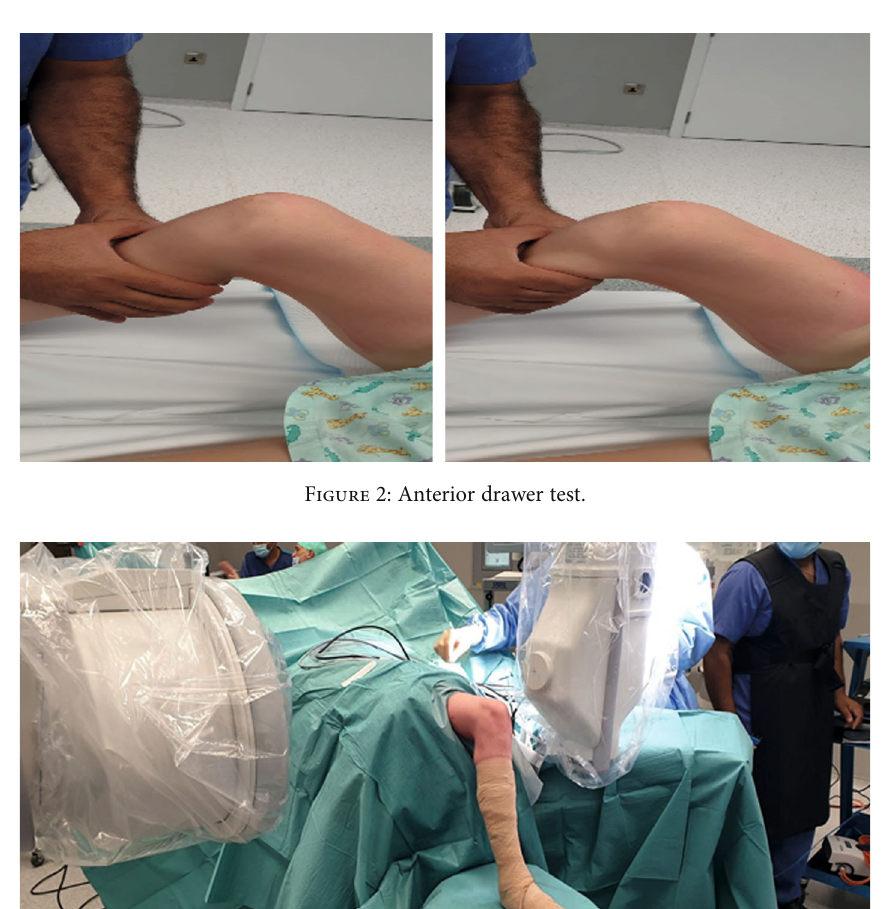
Figure 1: Lachman